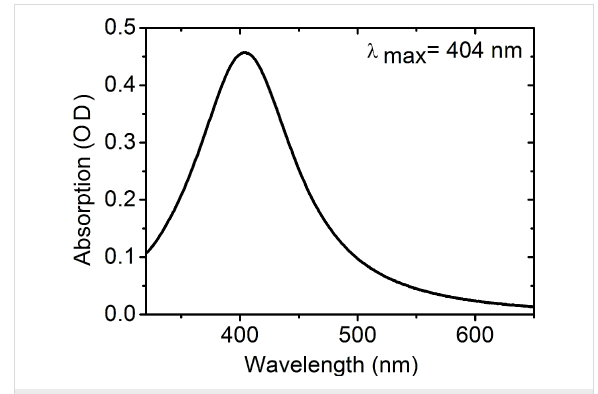
Figure 2: Absorption spectrum of AgNP-3MPS nanoparticles (synthesis b). The SPR exhibits a sharp peak at 404 nm with a FWHM of 92